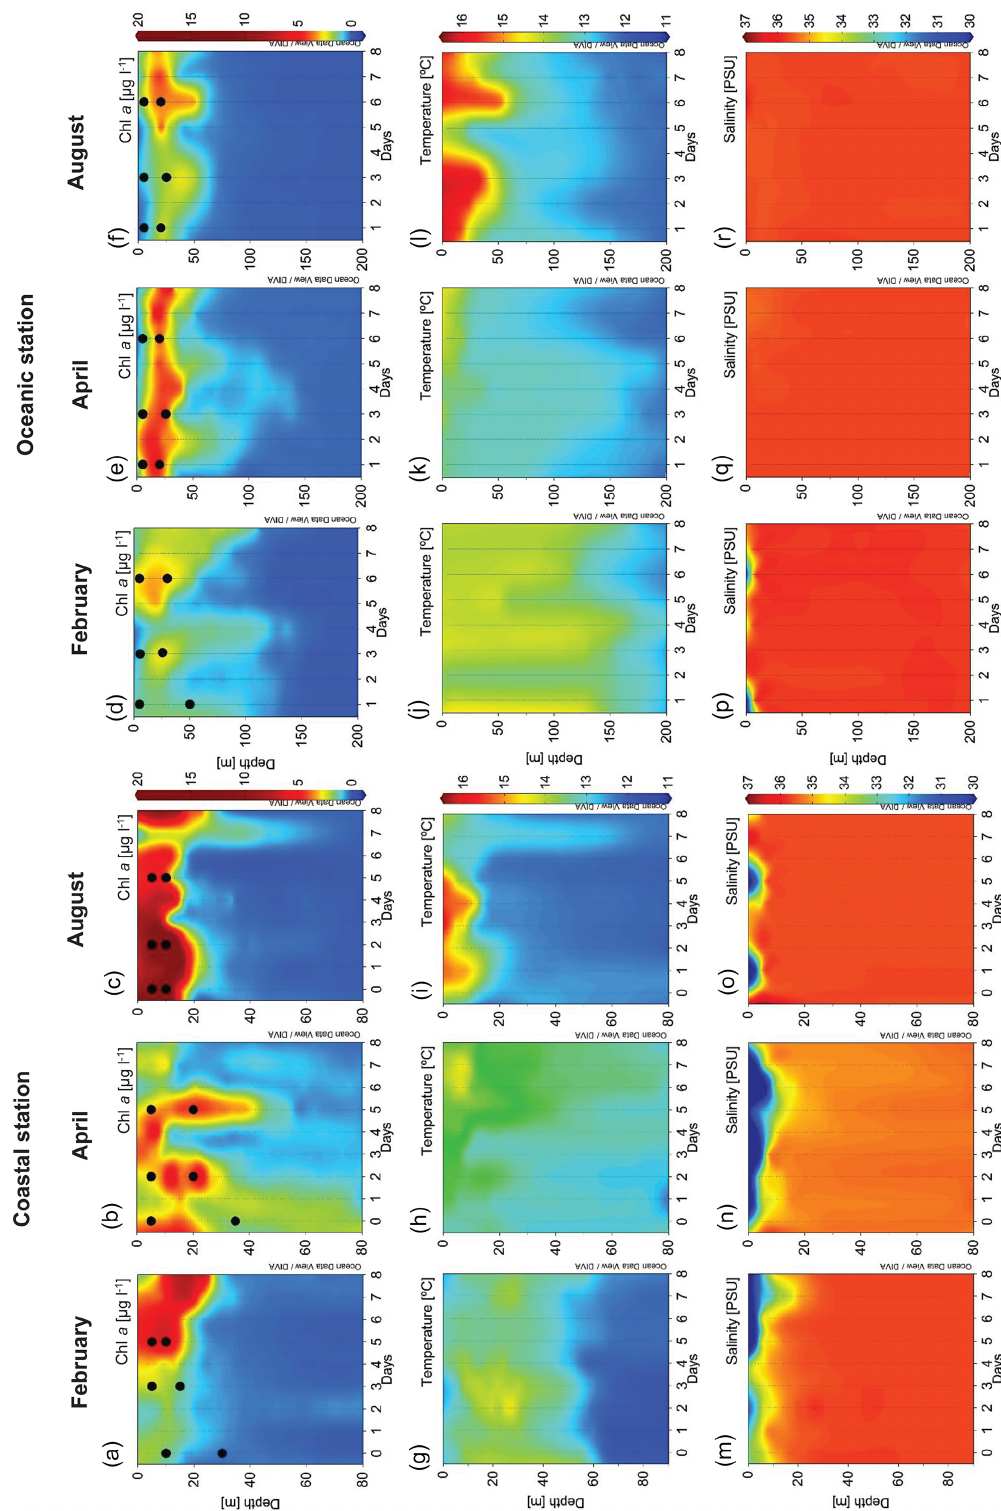
Figure 2. Vertical distribution over time in the coastal station of Chl a (µgL − 1 ) in (a) February, (b) April and (c) August; temperature ( ◦ C) in (g) February, (h) April and (i) August; and salinity (PSU) in (m) February, (n) April and (o) August. Vertical distribution over time in the oceanic station of Chl a (µgL − 1 ) in (d) February, (e) April and (f) August; temperature ( ◦ C) in (j) February, (k) April and (l) August; and salinity (PSU) in (p) February, (q) April and (r) August. Dots show the t 0 of the experiments. Chl a : chlorophyll a